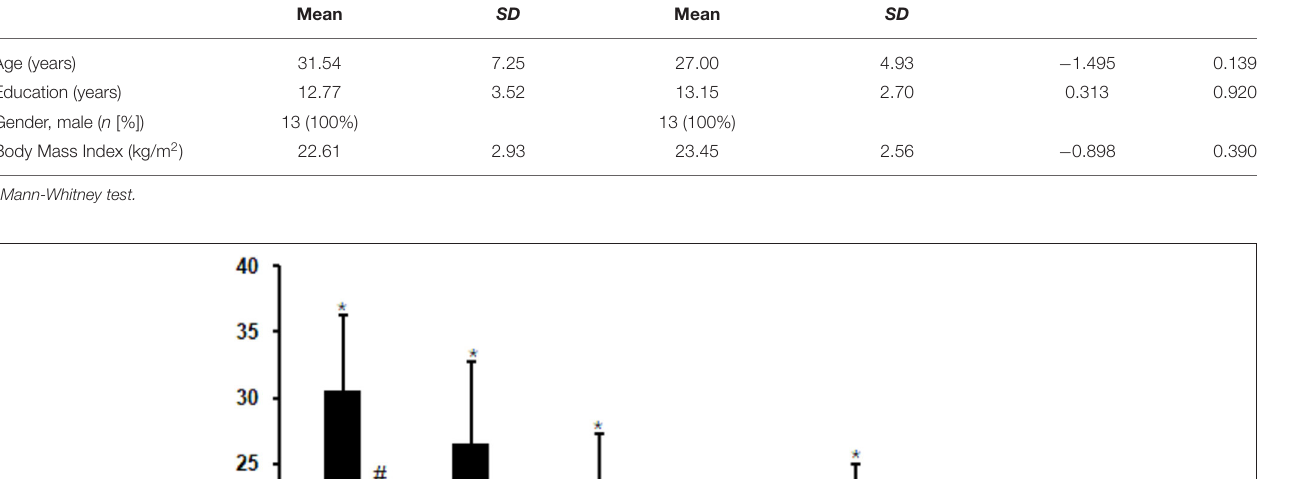
TABLE 1 | Clinical characteristics of HCs and MDD patients at baseline. Variable